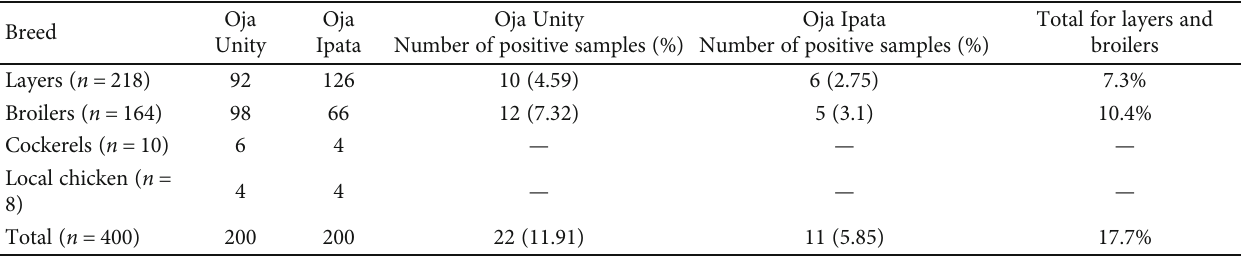
Table 3: Salmonella species isolated from di ff erent breeds of chickens in the Ilorin metropolis. Breed